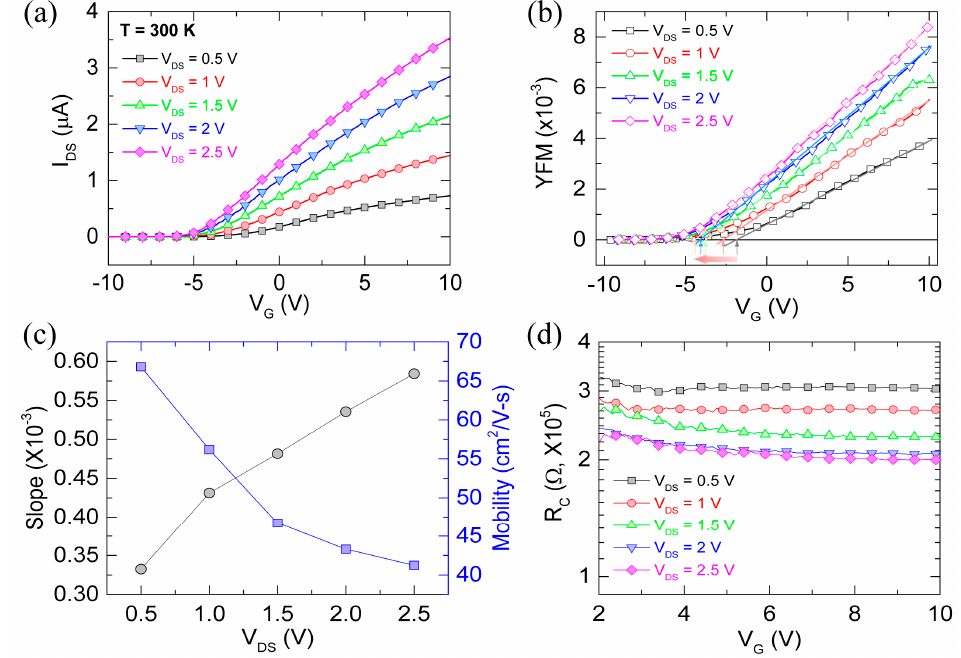
Figure 2. ( a ) I DS -V G curves measured at room temperature (T = 300 K) for the ZnO nanowire FET, with V DS varying from 0.5 to 2.5 V; ( b ) YFM value as a function of V G at different V DS values for the ZnO nanowire FET. From the linear fitting, V th and mobility can be extracted from the V G -axis intercept and the slope, respectively. Each arrow indicates the V th for each V DS ; ( c ) Slope and mobility as a function of V DS extracted from linearly fitted curves in ( b ); ( d ) Contact resistance as a function of gate bias, with V DS varying from 0.5 to 2.5 V.